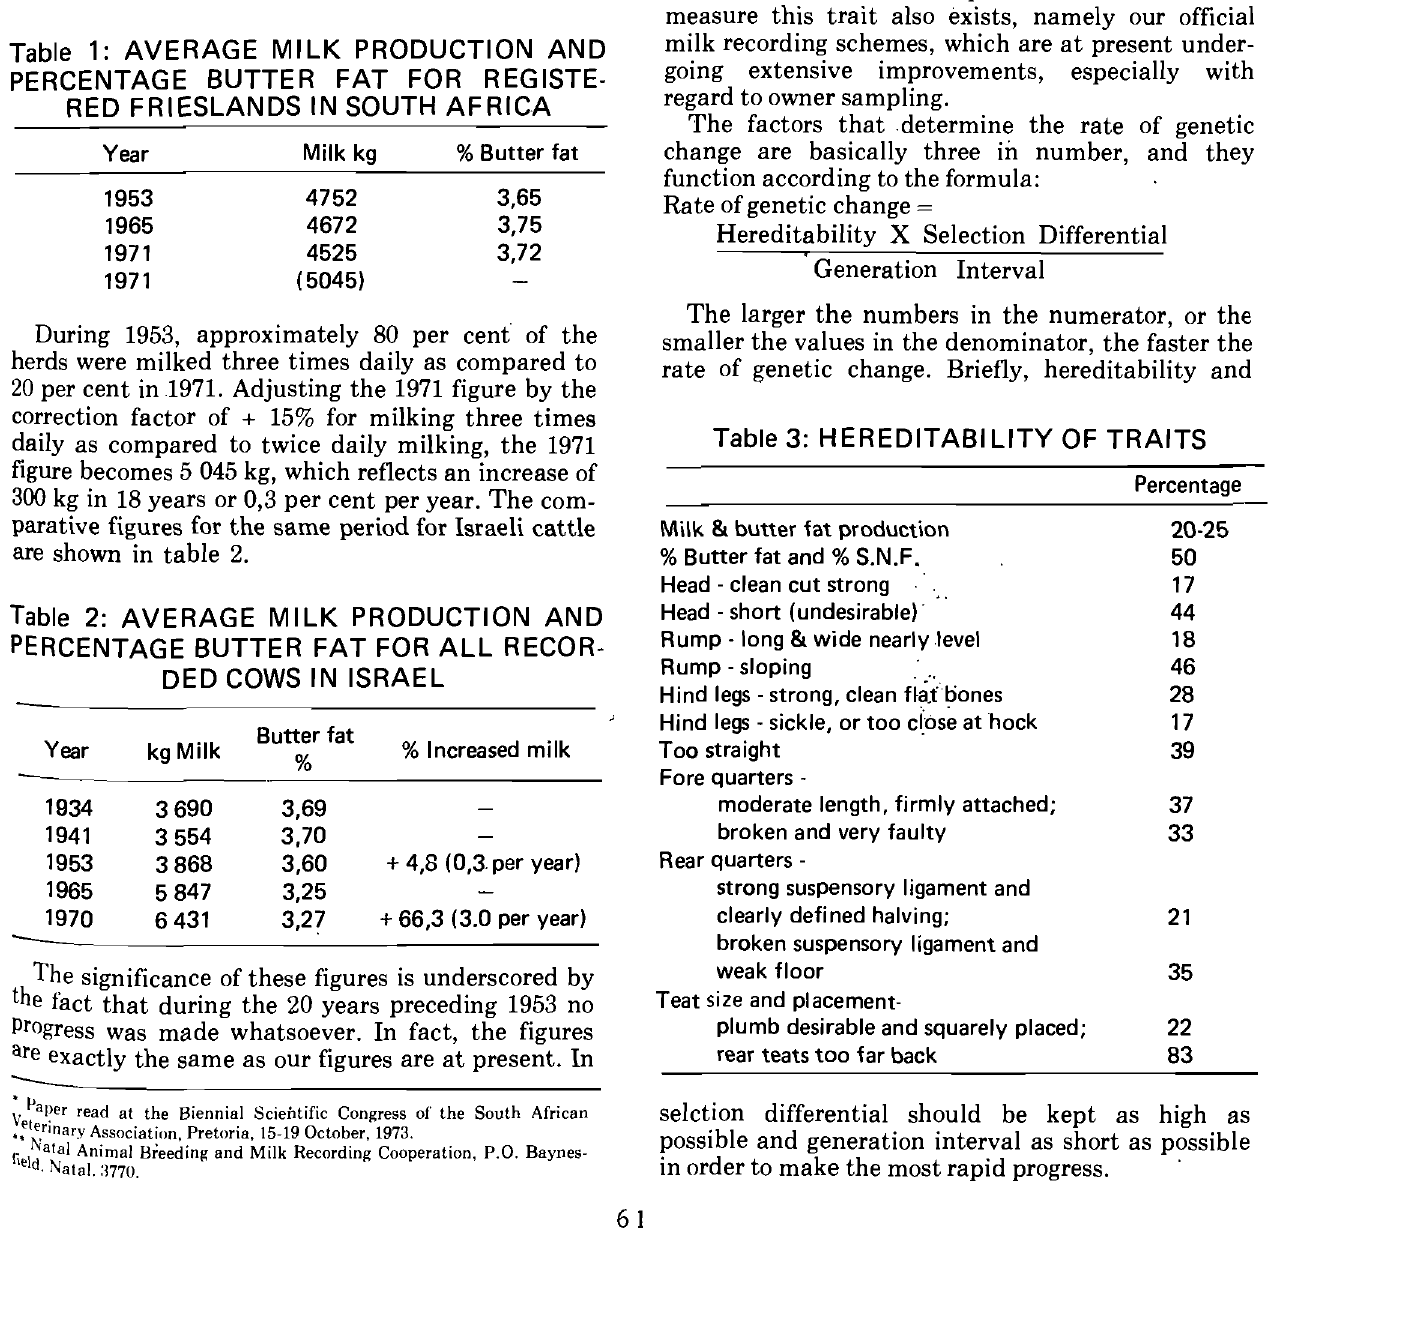
Table 1: AVERAGE MILK PRODUCTION AND PERCENTAGE BUTTER FAT FOR REGISTE RED FRIESLANDS IN SOUTH AFRICA